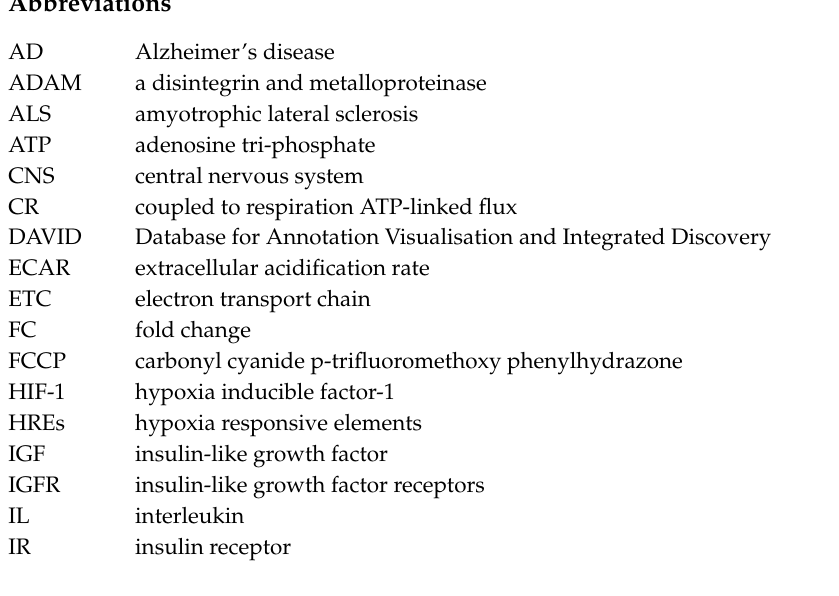
Table S1: Genes upregulated in human astrocytes in response to hypoxia. Table S2: Genes downregulated in human astrocytes in response to